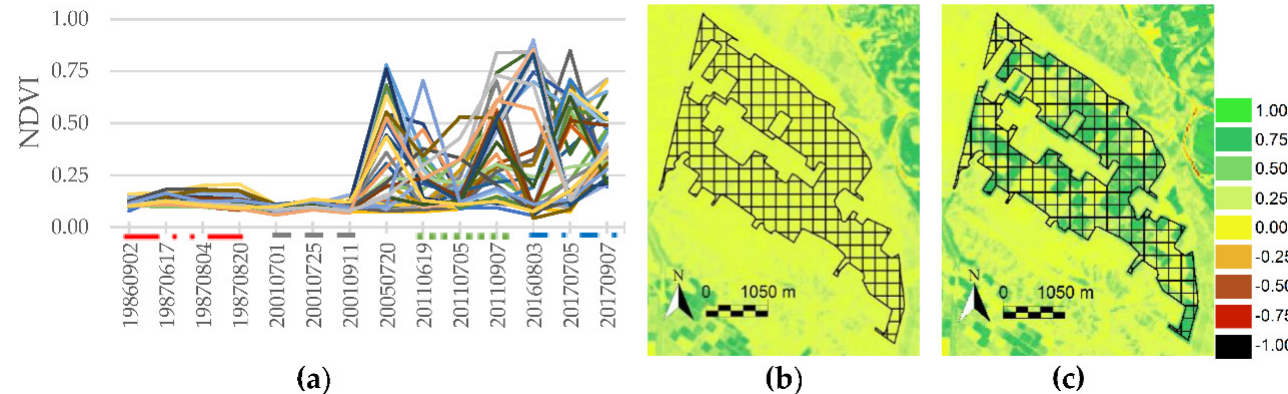
Figure 4. The NDVI summer multiannual profile of irrigated herbaceous crops is shown. Colour lines in ( a ) represent the median value of the pixels within polygon tiles. For the sake of simplicity, a random third of the tiles are represented. The red, grey, green and blue dotted lines over date figures denote the imagery (summer months), including 20 July 2005, as a date that is contemporary to the rDS. In ( b , c ), the polygon is represented in black over two summer dates NDVI (25 July 2001, and 20 July 2005). Note that during the first time period, the pattern is highly stable.